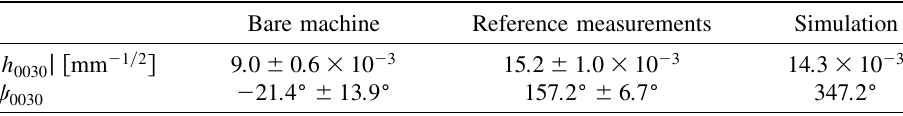
TABLE V. Overview on resonance strengths and phases for the bare machine and in case of excitation. Bare machine Reference measurements